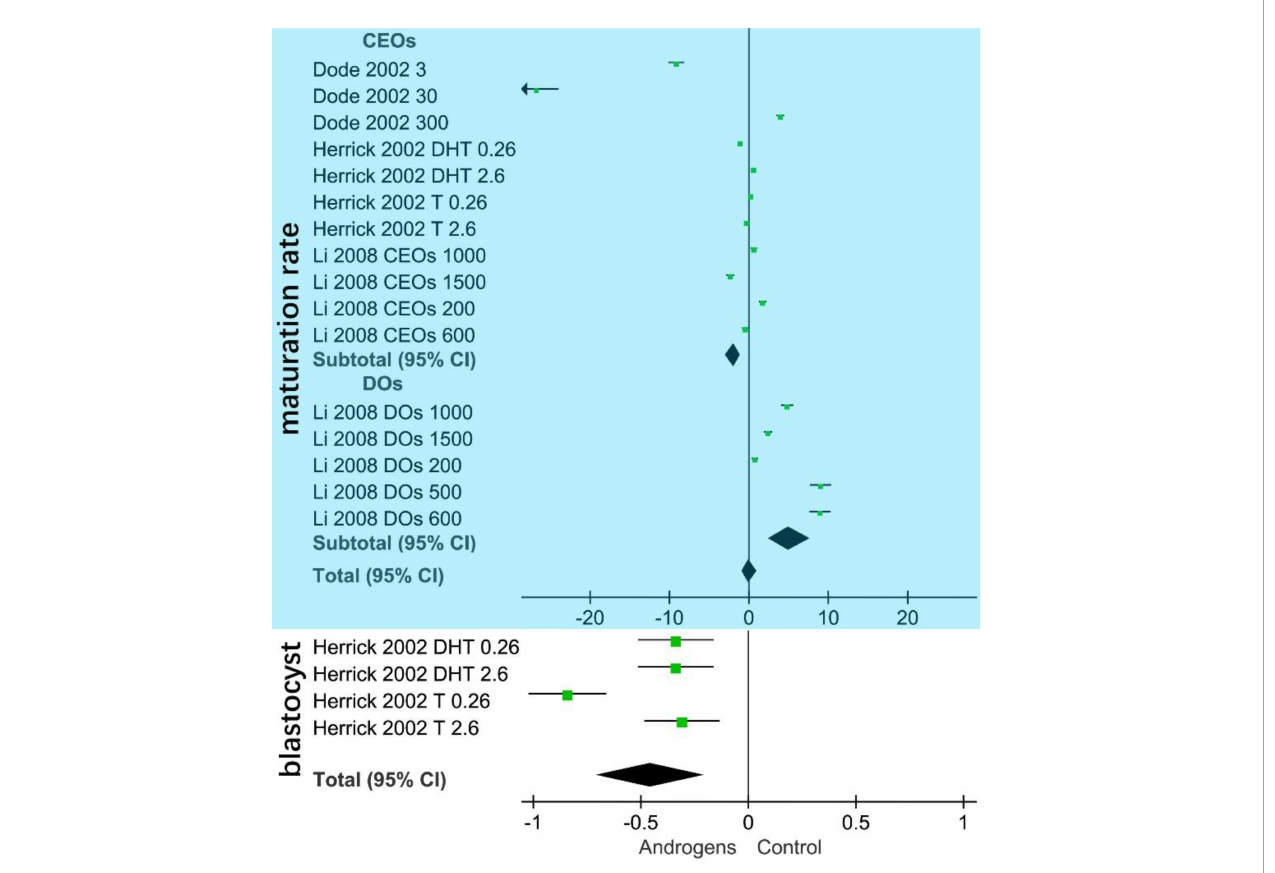
FIGURE 3 Forest plot of in vitro androgen effects on swine oocytes. The area of the green square in the fi gure represents the weight of each data set of the meta- analysis. The upper blue part shows the CEOs (COCs, cumulus – oocyte complexes) are negatively correlated with oocyte maturation in vitro . Denuded oocytes (DOs) are positively related to oocyte maturation. The lower white part shows that androgen (total SMD = – 0.46, 95% CI= – 0.70 to – 0.21; p < 0.001) is negatively correlated with the in vitro swine blastocyst